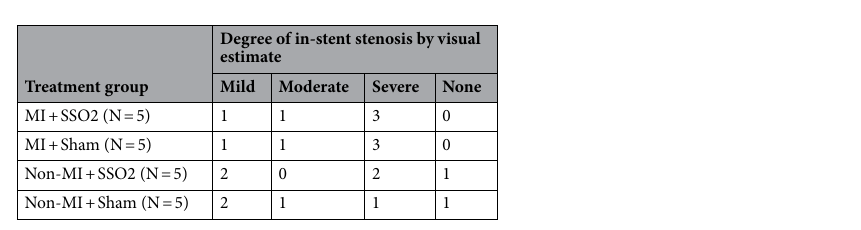
Table 3. Incidence of in-stent stenosis in 30-day